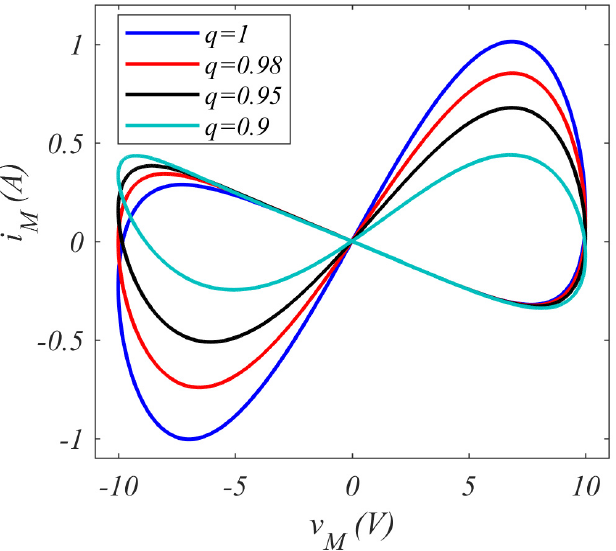
Figure 2. 𝑣 (cid:3014) − 𝑖 (cid:3014) characteristics of fractional-order memristor described by Equation (8). Figure 2. v M − i M characteristics of fractional-order memristor described by Equation